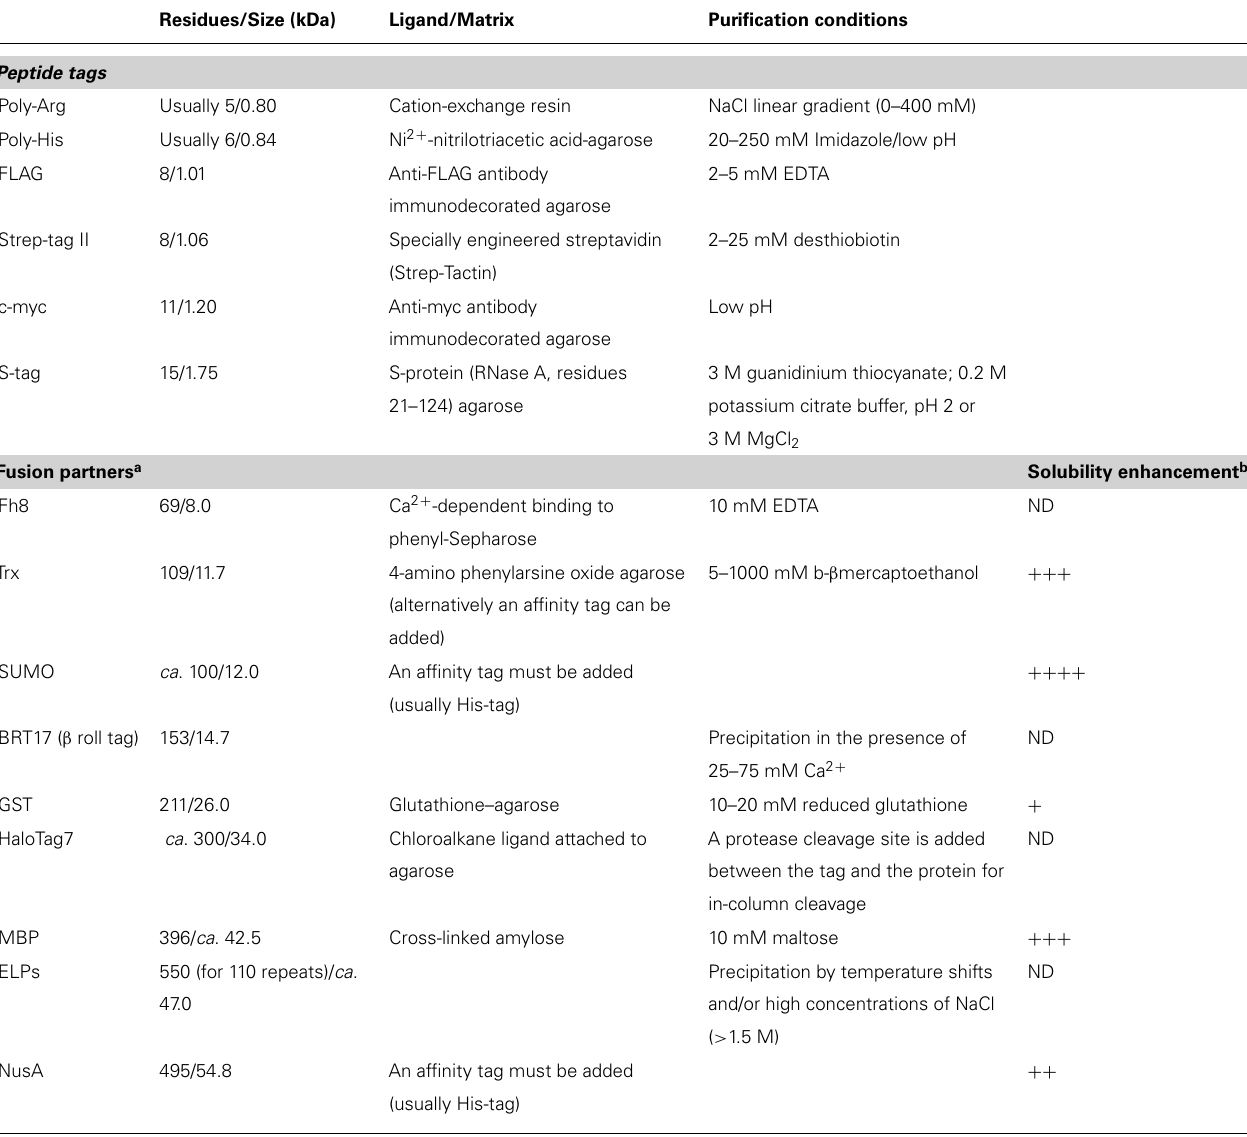
Table 1 | Main characteristics of protein fusion